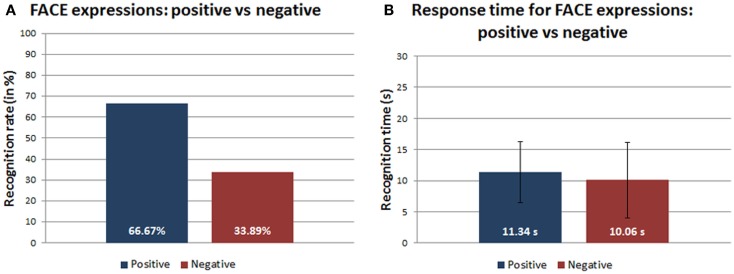
(A) Recognition rates (in percentage) and (B) response time (in seconds) of positive/negative robot expressions.